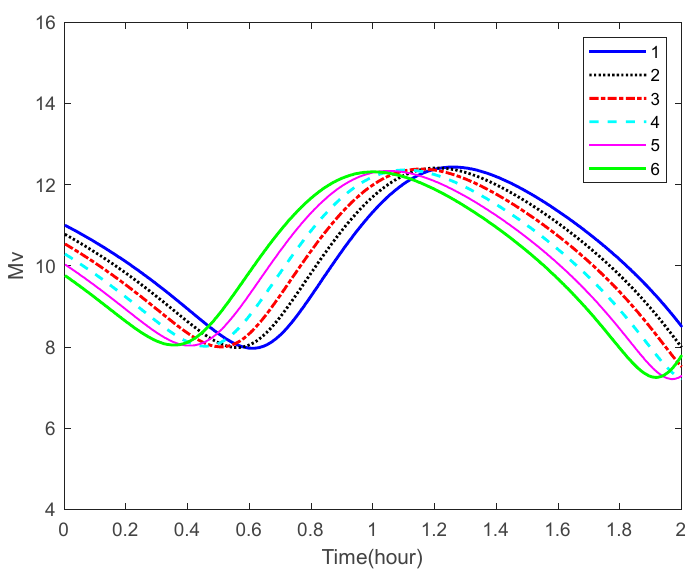
sensitivity of the star camera in Algorithm 1 is 8 Mv, some space targets are bright enough to be observed in certain areas of the orbit.